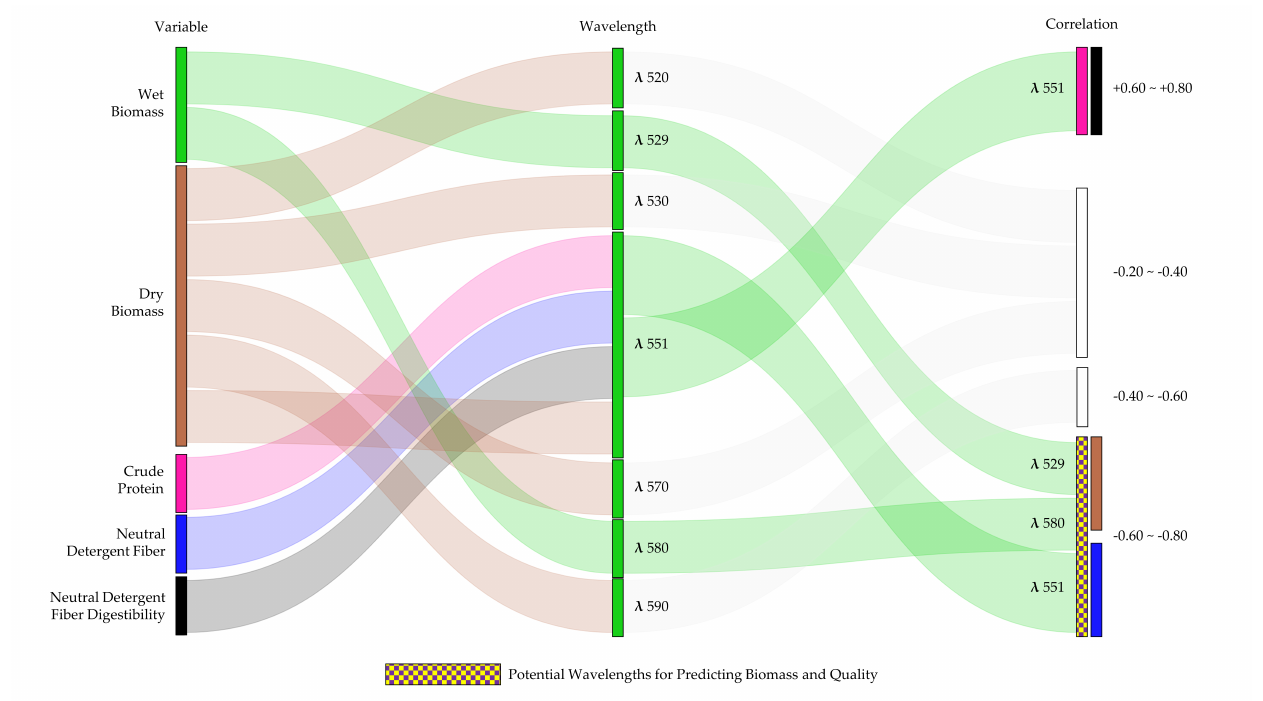
Figure A2. Sankey diagram illustrates the wavelengths in the green region ( λ 520 − 590) most correlated with alfalfa biomass and quality traits. The flow chart intuitively displays bars and paths drawn in proportion to the amount of information used. The larger the bars, the more times this information has been used. Colored pathways assign the connections between alfalfa biomass and quality traits and its usage in remote sensing data (i.e., wavelengths or vegetation indices) as well as its response to the strength of the correlation. When wavelength or vegetation indices have the potential to be used to establish a relationship with biomass and quality traits, they are marked. The colors of each correlation bar are linked to the biomass and quality traits. When it is white, it is because it has no potential to be used. However, when the bar is colored and checkered, it indicates that although it has not been used to study its relationship with quality, it has the potential to predict it assuming its correlation with